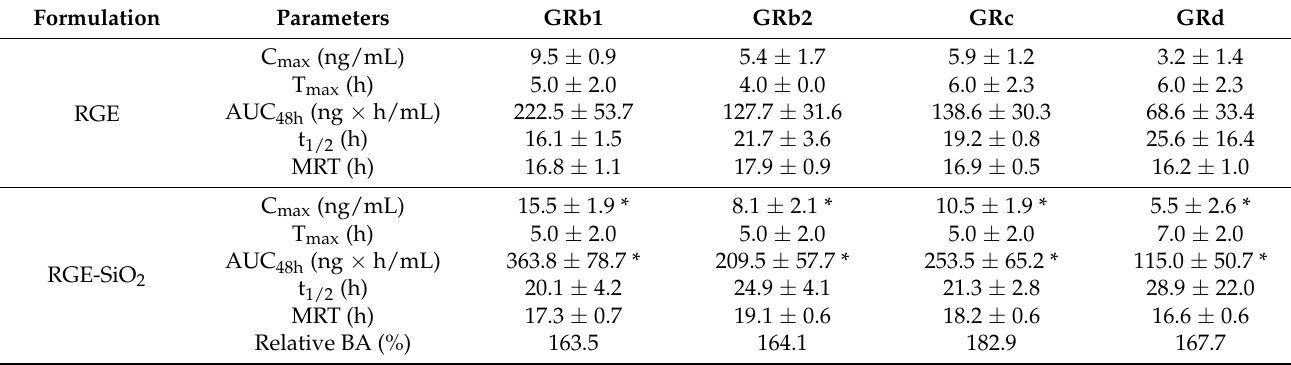
C max , maximum plasma concentration; T max : time to reach C max ; AUC, area under the curve; t 1/2 , half-life; MRT, mean residence time; relative BA, relative bioavailability (AUC RGE-SiO2 /AUC RGE × 100). * p < 0.05, statistically significant compared with RGE group by the Student t -test. Data represent the means ± standard deviation ( n =